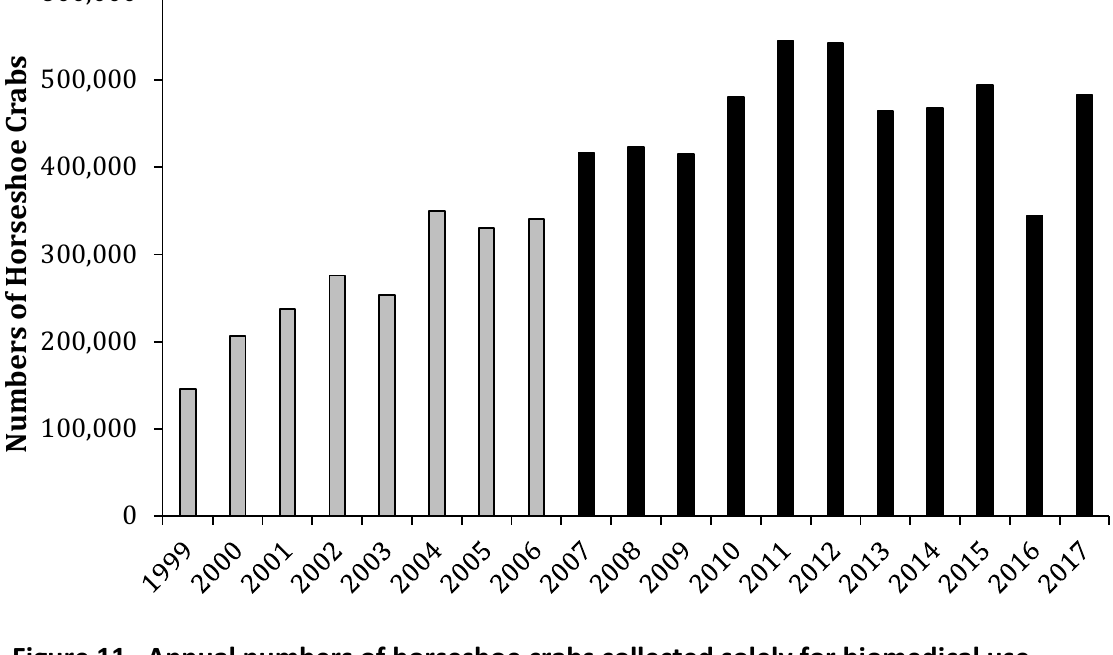
Figure 11. Annual numbers of horseshoe crabs collected solely for biomedical use coastwide. These numbers do not include crabs that entered the bait market after bleeding. Black bars indicate years in which all states reported collection numbers, and grey bars indicate years that include imputed values for at least one state due to missing data when collections were known to have occurred.